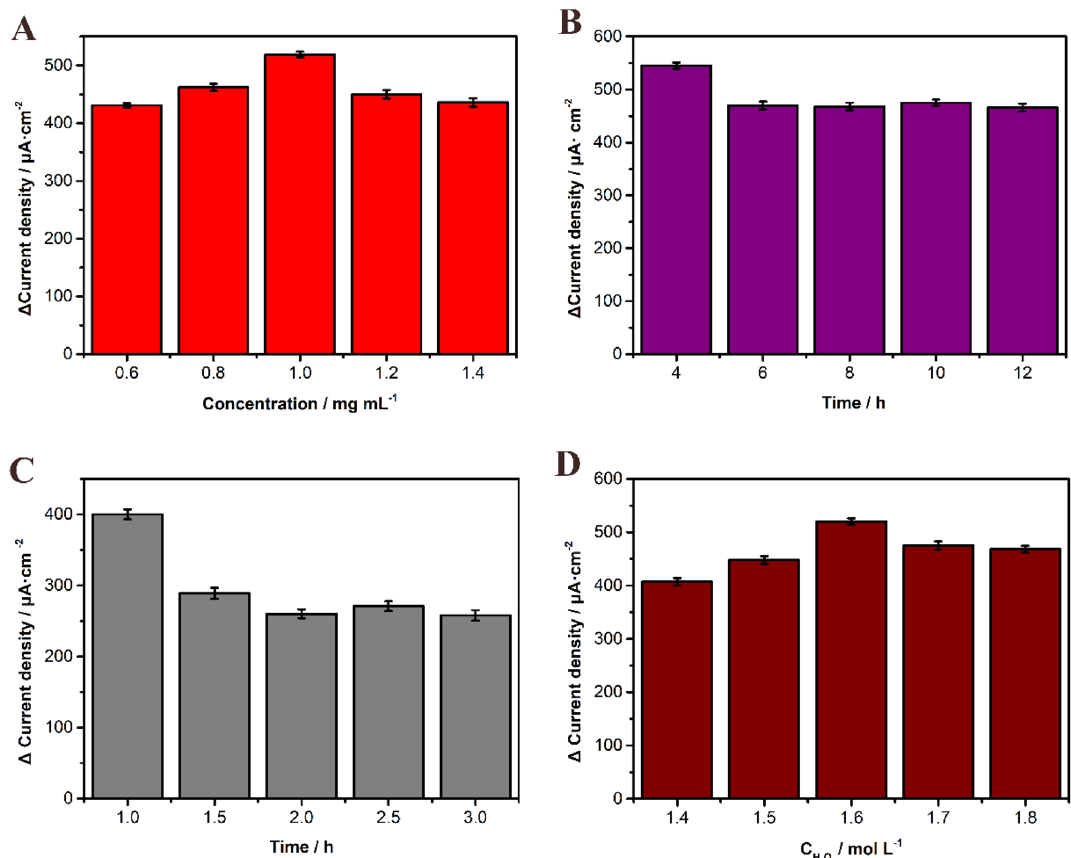
Figure 4. Optimization of the experimental conditions: ( A ) the concentration of Cu@L-Asp/Pd–Pt NPs nanocomposites; ( B ) the incubation time of anti-SPOP; ( C ) the reaction time of SPOP; ( D ) the concentration of H 2 O 2